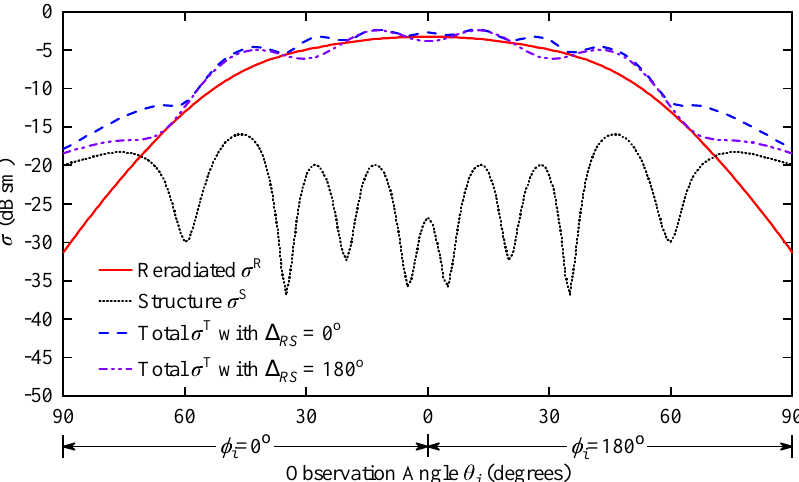
Figure 22. The monostatic RCSs based on the reradiated, scattered, and the total fields when the phase difference ( ∆ RS ) between E R and E S is 0 ◦ and 180 ◦